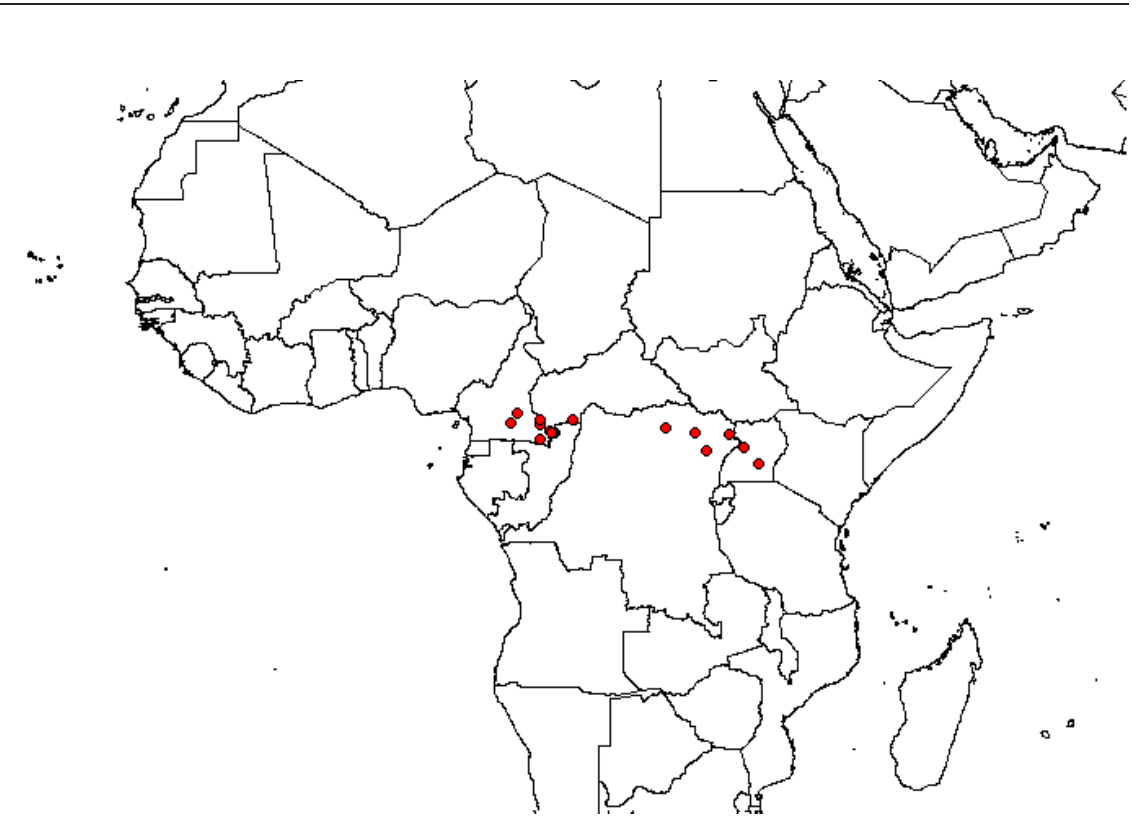
Fig. 8. Distribution map for Desplatsia mildbraedii